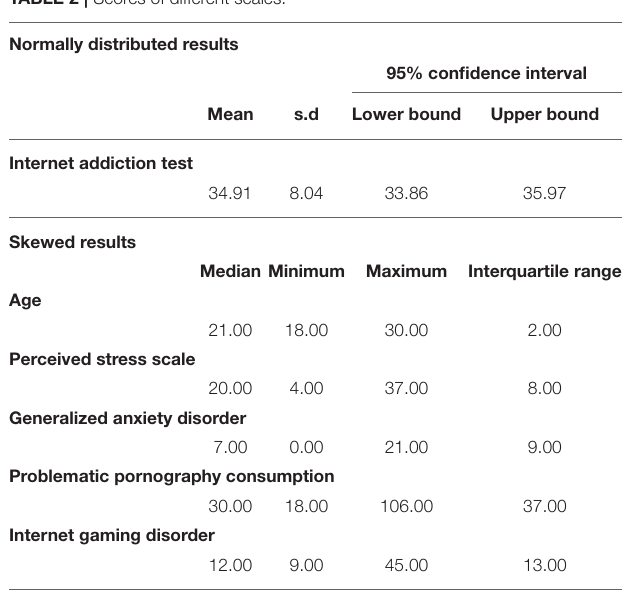
TABLE 2 | Scores of different